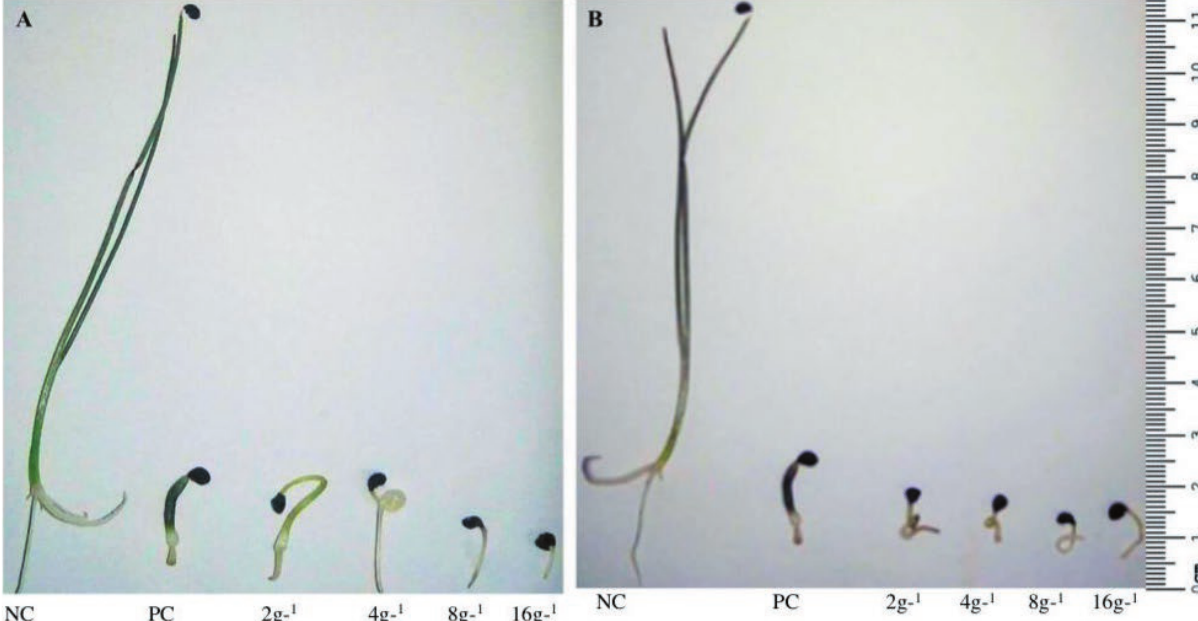
Figure 1. Seedlings of Allium cepa after 28 days of exposure to the decoctions of (A) Aristolochia labiata and (B) Aristolochia triangularis . NC = negative control - culture medium (Murashige and Skoog, 1962); PC = positive control (0.025%